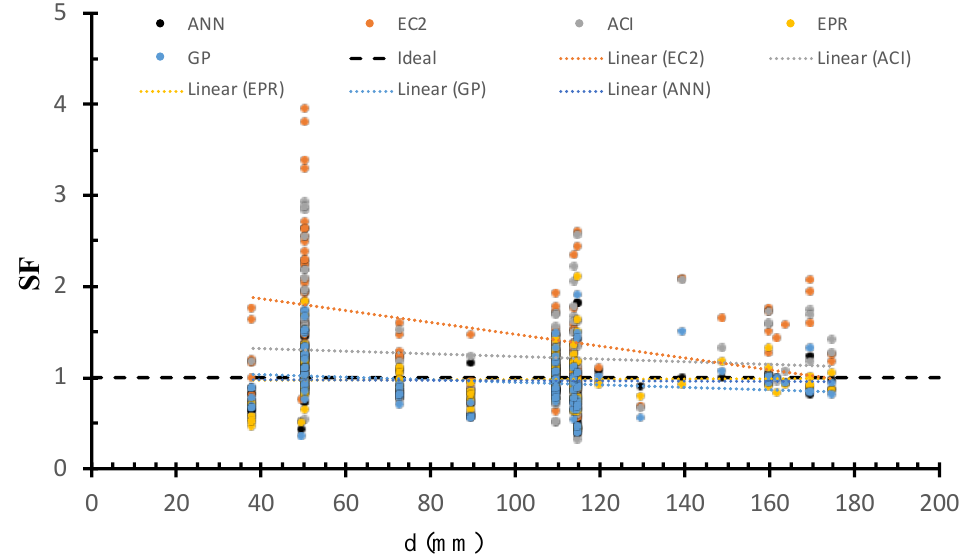
Figure 8. SF calculated using various models versus 𝑑 .